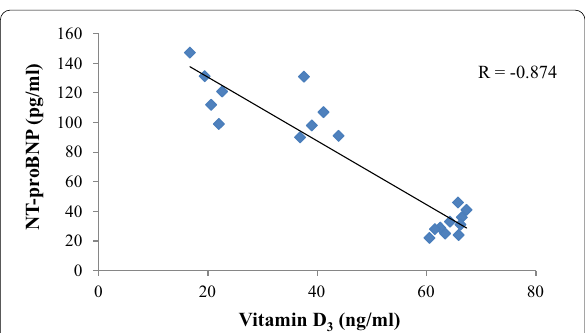
Fig. 1 The correlation between serum vitamin D 3 and NT‑proBNP in 33 diarrheic calves. The graph illustrates a strong negative correlation ( r 0.874) between vitamin D 3 (ng/ml) and NT‑proBNP (pg/ml), = − r Pearson correlation coefficient =